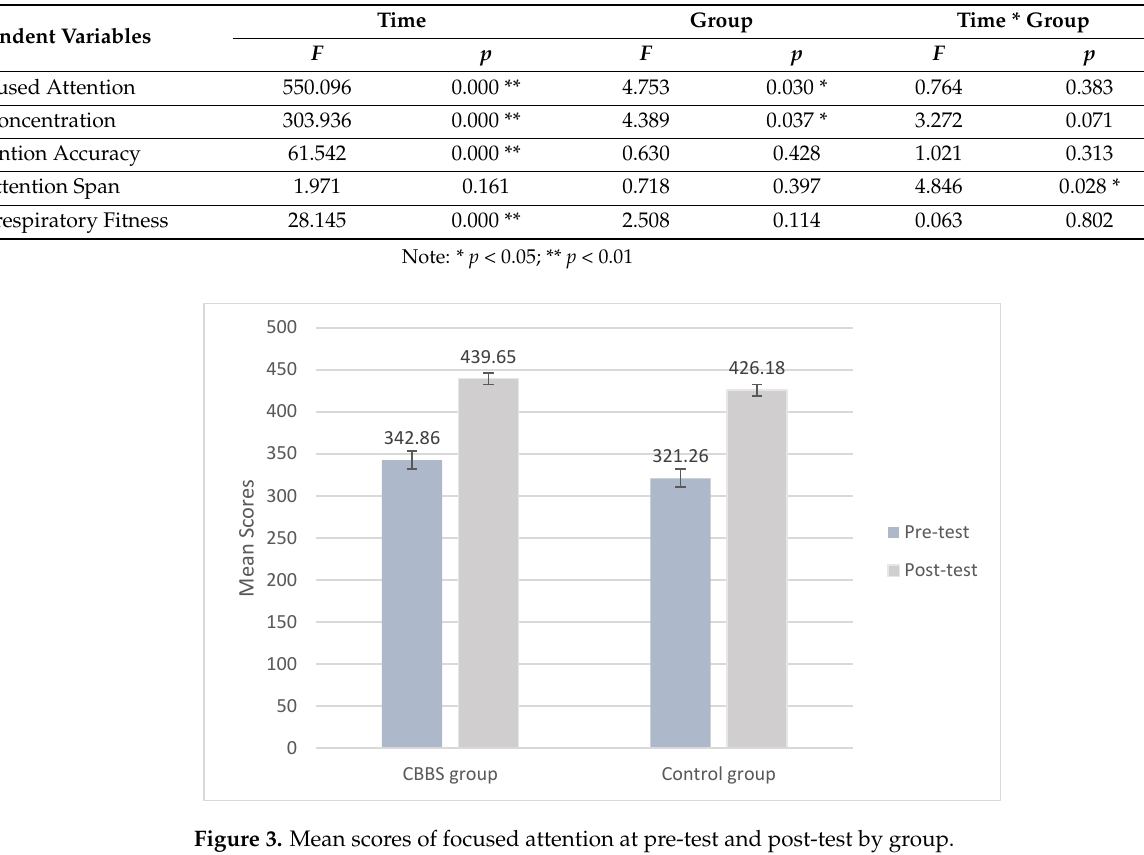
Table 3. Results of Linear Mixed Models for outcome variables.